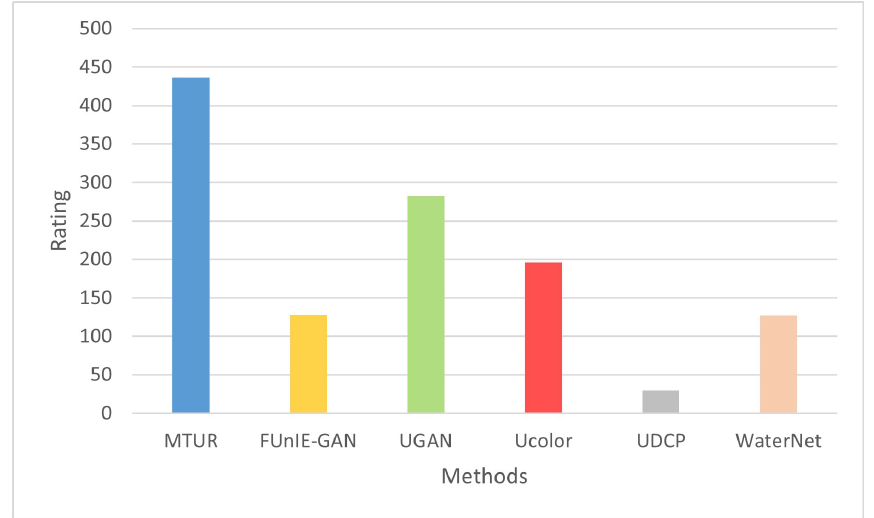
Figure 6. The generated image equality evaluation results of different methods on